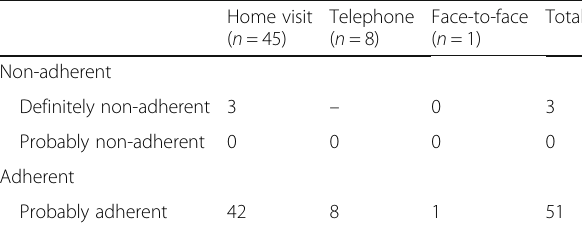
Table 2 Number of adherent and non-adherent patients according to follow-up interview (n = 54)